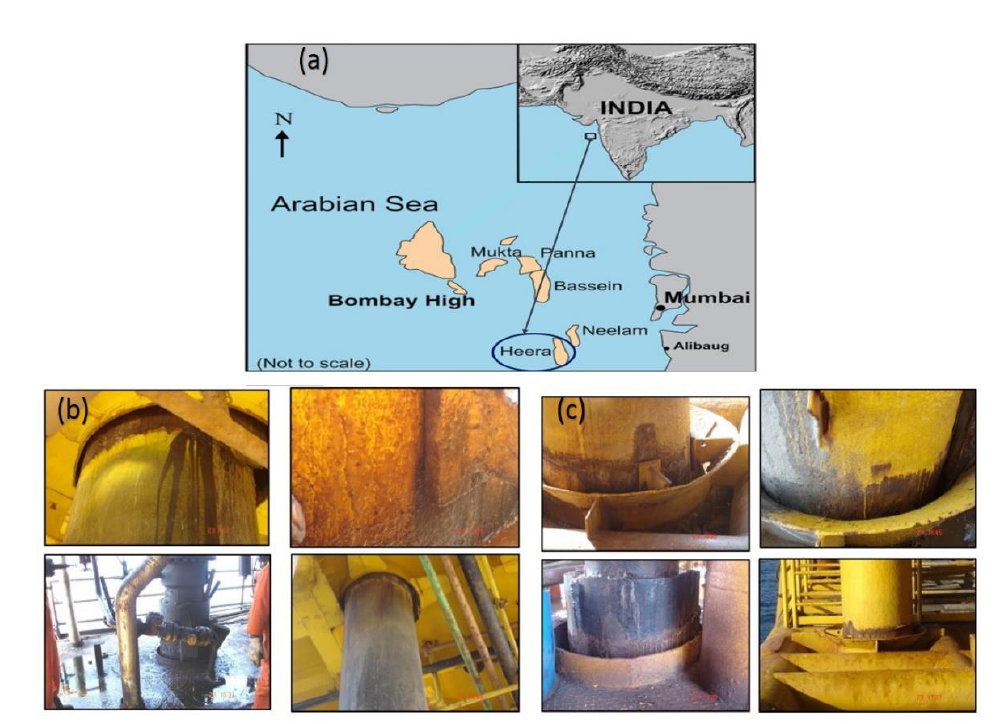
Figure 2. (a) Location map of the North-Heera field in the Mumbai offshore, (b) Noticeable subsidence occurred in one of the platforms and wells, (c) Upliftment of the offshore wells and platform in Mumbai